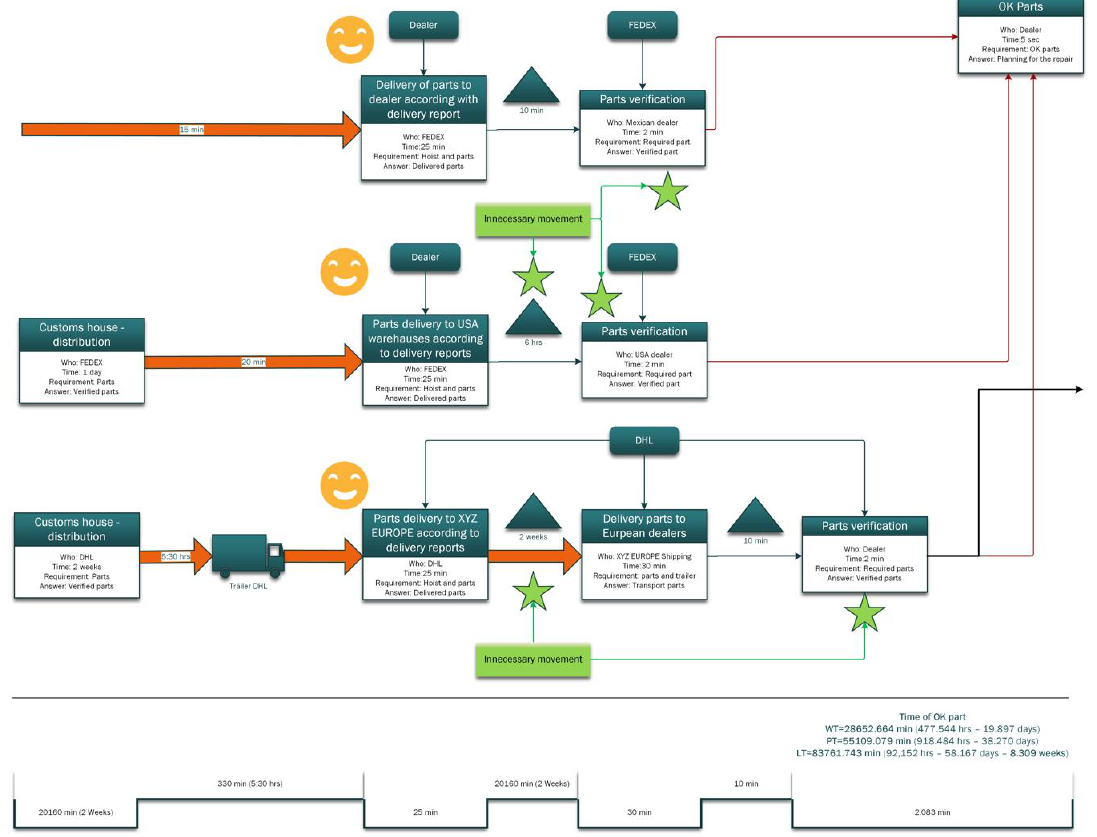
Figure 15. The sixth part of seven of the Current State Value Stream Map with wastes.